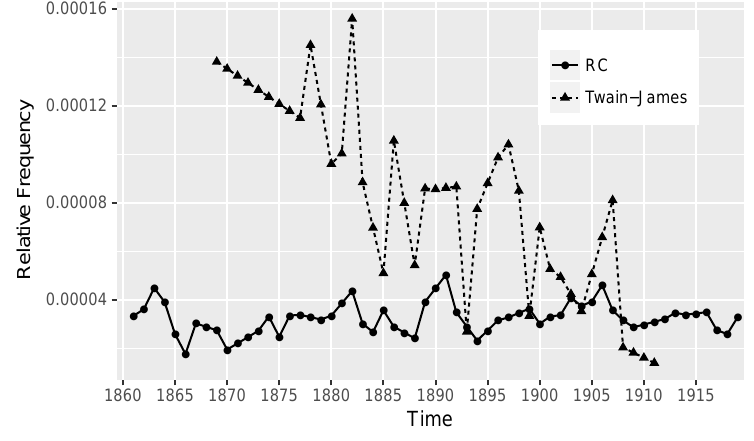
Figure 1: The development over time of the tetragram h VBD VBN IN JJ i , showing relative frequency in relation to all tokens for the reference corpus (RC) and for the two